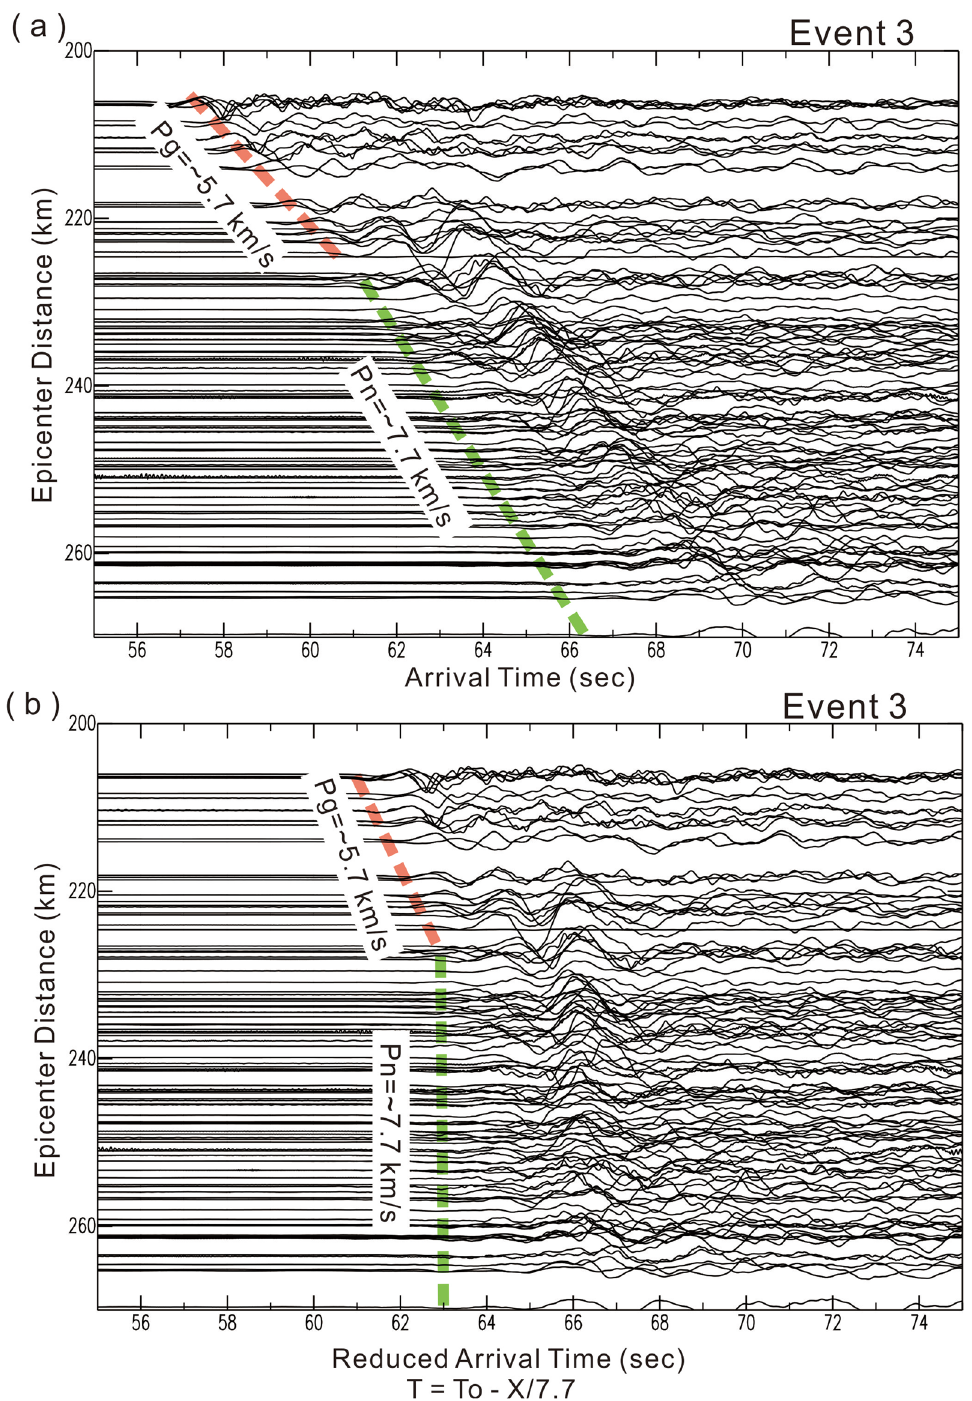
Fig. 6 Vertical seismograms generated by Event 3 and recorded by the Formosa Array. Seismograms a directly plotted with epicenter distances, and b with arrival times corrected by a reduced velocity of 7.7